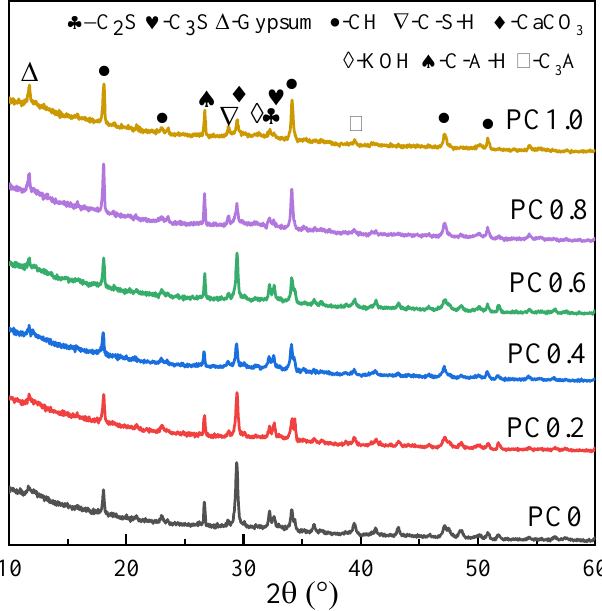
Figure 1. XRD patterns of various cement specimens.